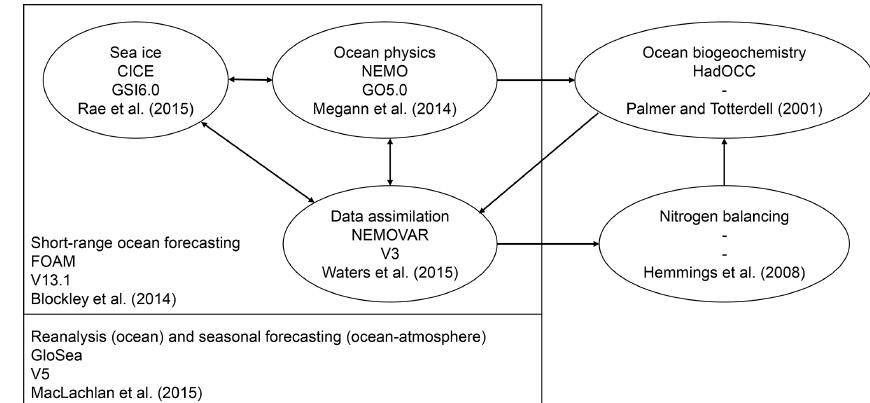
Figure 1. Model and assimilation setup used. Arrows denote the direction of